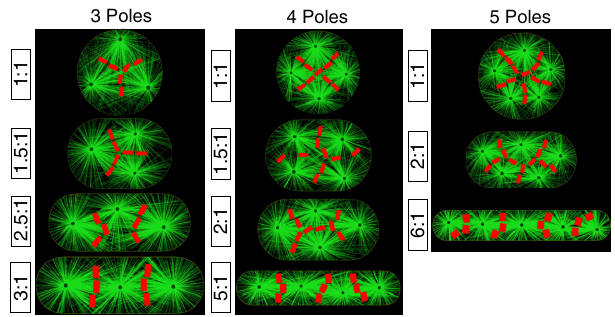
FIG. 10. Four-wall confinement changing cell shape, which in turn effectively regulates the configuration of multipolar spindles. The multipolar spindles will change from regular polygons to a chain of smaller bipolar spindles when the aspect ratio of the cell